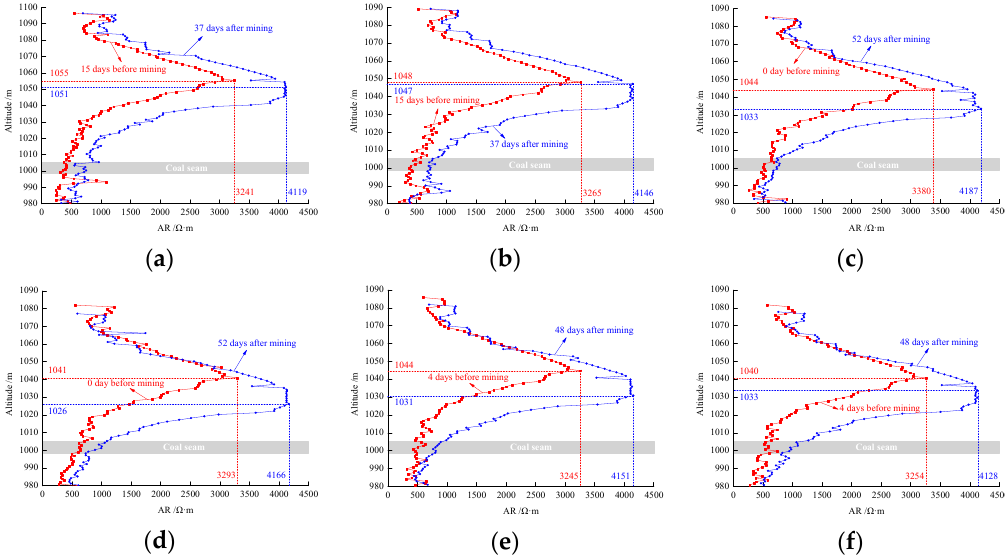
Figure 8. The AR distribution of characteristic points before and after mining: ( a ) Point A21; ( b ) Point A35; ( c ) Point B20; ( d ) Point B35; ( e ) Point D16; ( f ) Point D26.